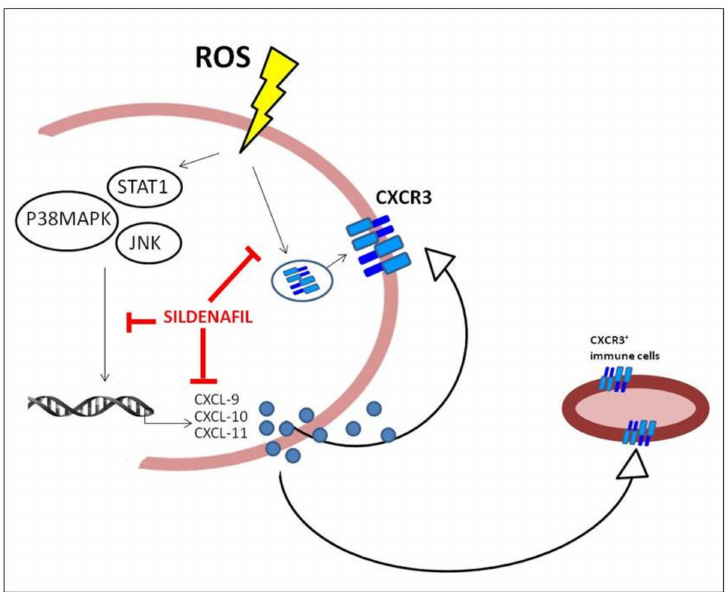
Figure 5. Suggested mechanism of action of sildenafil on SSc fibroblasts. After a pro-oxidant stimulus, the cell activates intracellular pathways that rapidly induce both the translocation of the CXCR3 receptor on the plasma membrane and the phosphorylation of downstream signaling molecules such as STAT1, JNK and p38MAPK. These proteins adapt the DNA response inducing the expression and release of the pro-inflammatory chemokines CXCL-9, CXCL-10 and CXCL-11. The binding of these chemokines to the specific receptor CXCR3 on the plasma membrane increases and amplifies the pro-inflammatory response towards autocrine/paracrine action and recruits CXCR3+ immune cells to tissue damage. The action of sildenafil results in an impairment of CXCR3 recruitment on the plasma membrane and in the counteraction of the transduction pathway responsible for chemokines expression and release. This can determine the reduction of the inflammatory activation loop at the site of